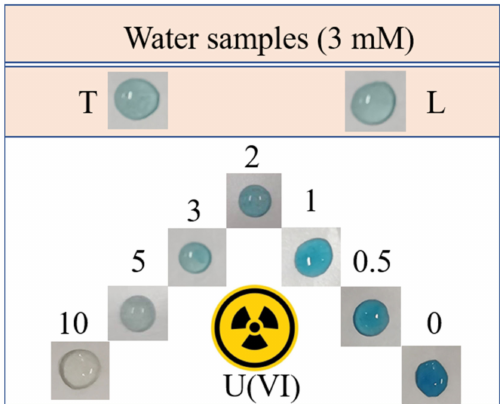
Figure 6. Photographs of the paper-based sensor under white-light LED lamp irradiation with the addition of different content of UO 22+ . T: tap water, L: lake